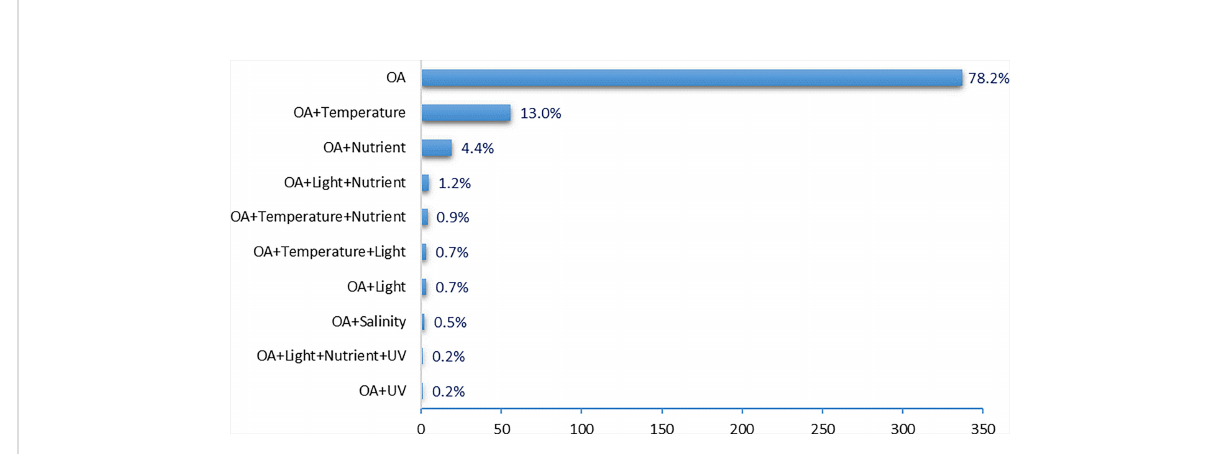
FIGURE 9 The multi-stressors/drivers manipulated in OA experimental